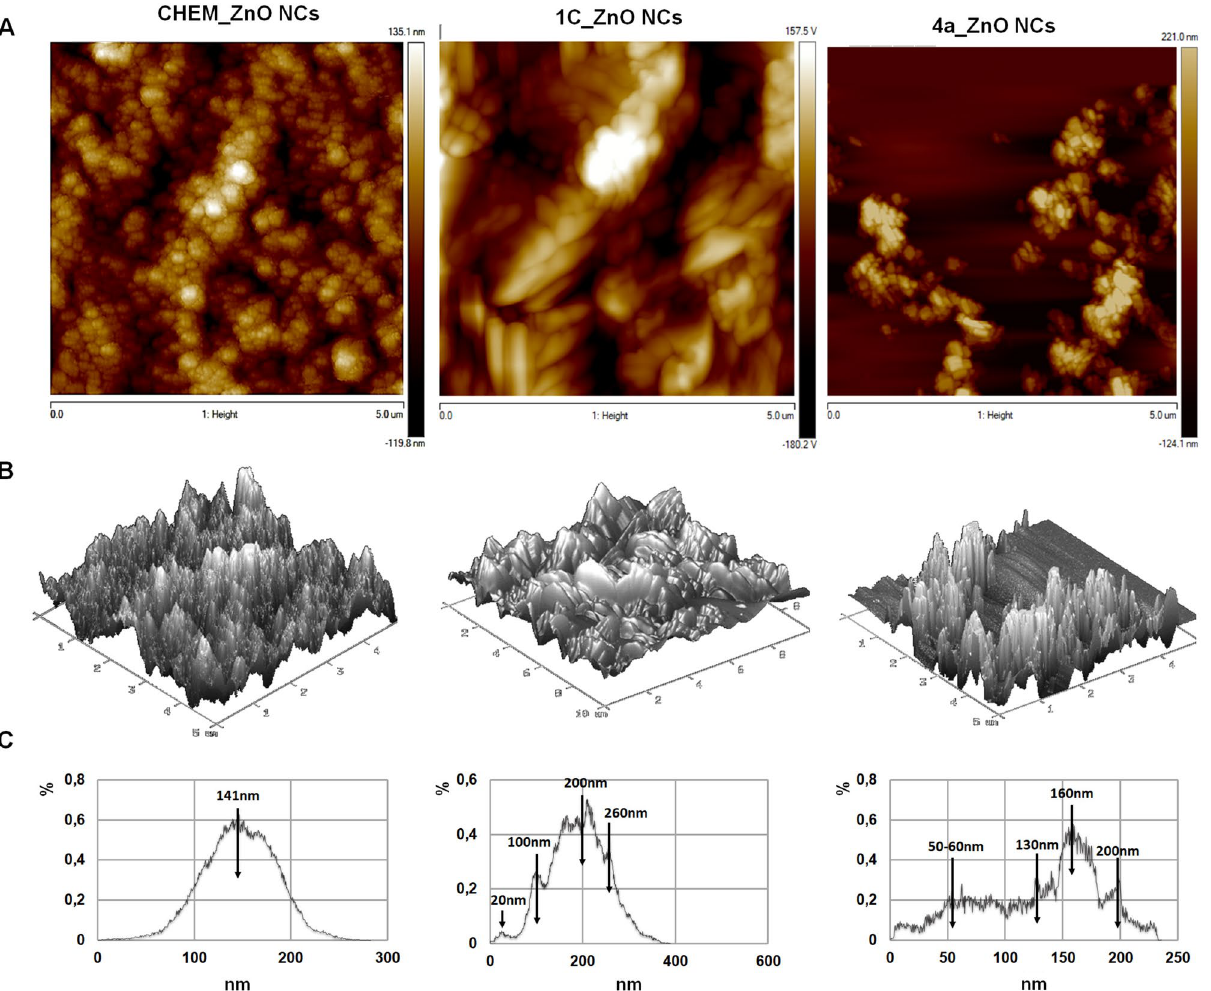
Figure 4. The AFM 2D ( A ) and 3D ( B ) images of chemically synthesized CHEM and biologically synthesized: 1C and 4a_ZnO NCs; the size population distribution ( C